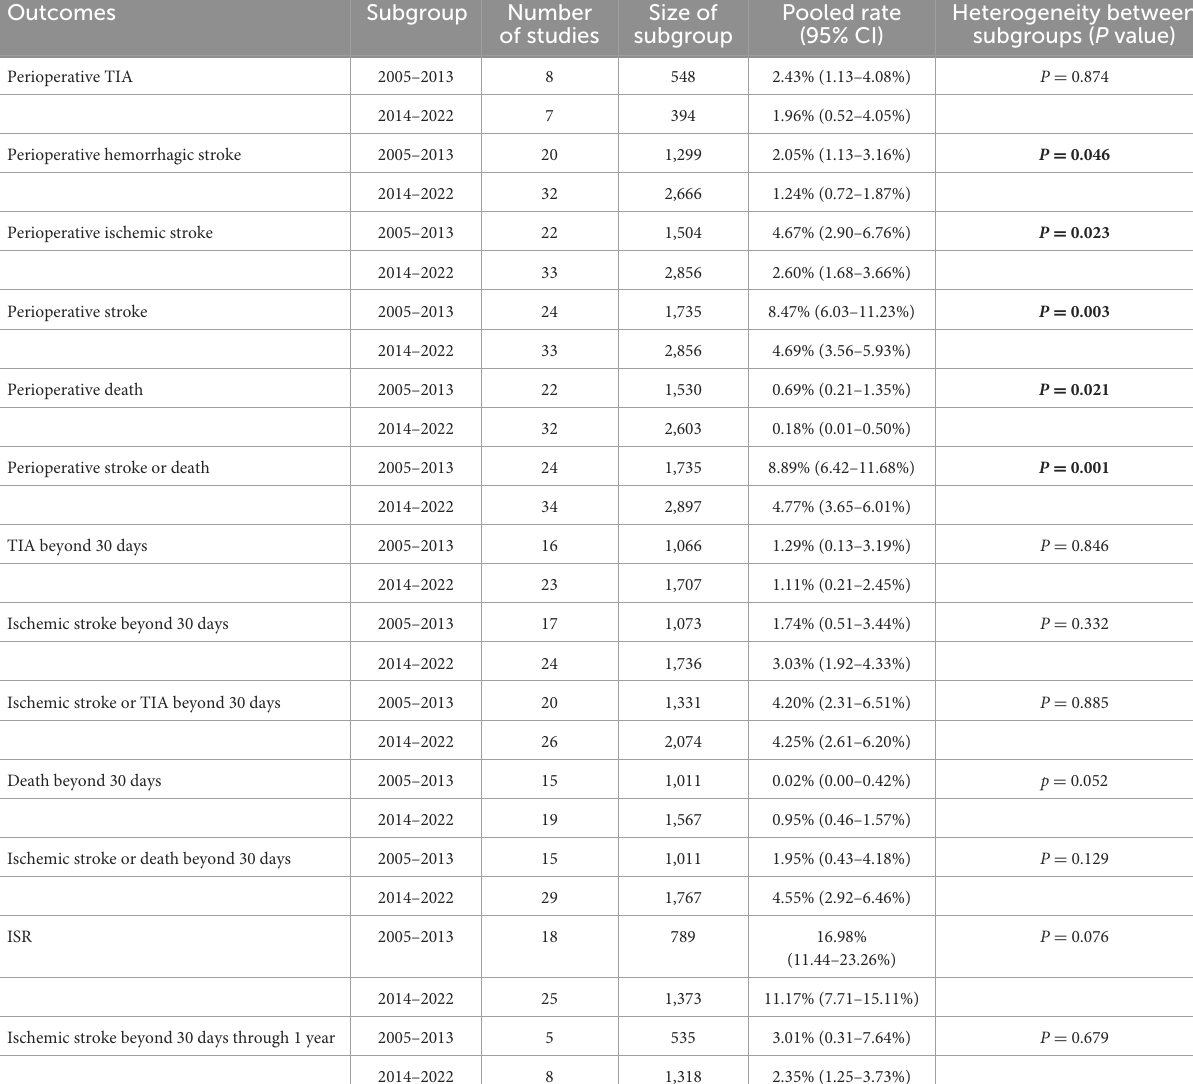
TABLE 3 Summary of subgroup analyses based on publication time.